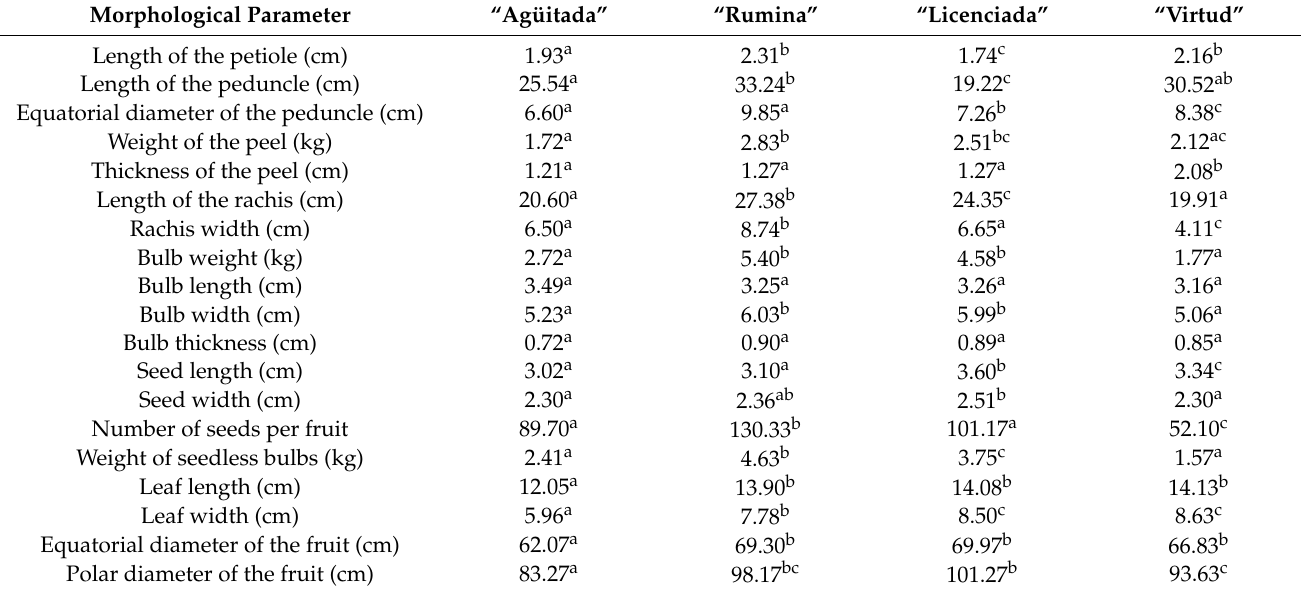
Table 1. Morphological Analysis of Four Jackfruit Genotypes from the State of Nayarit,